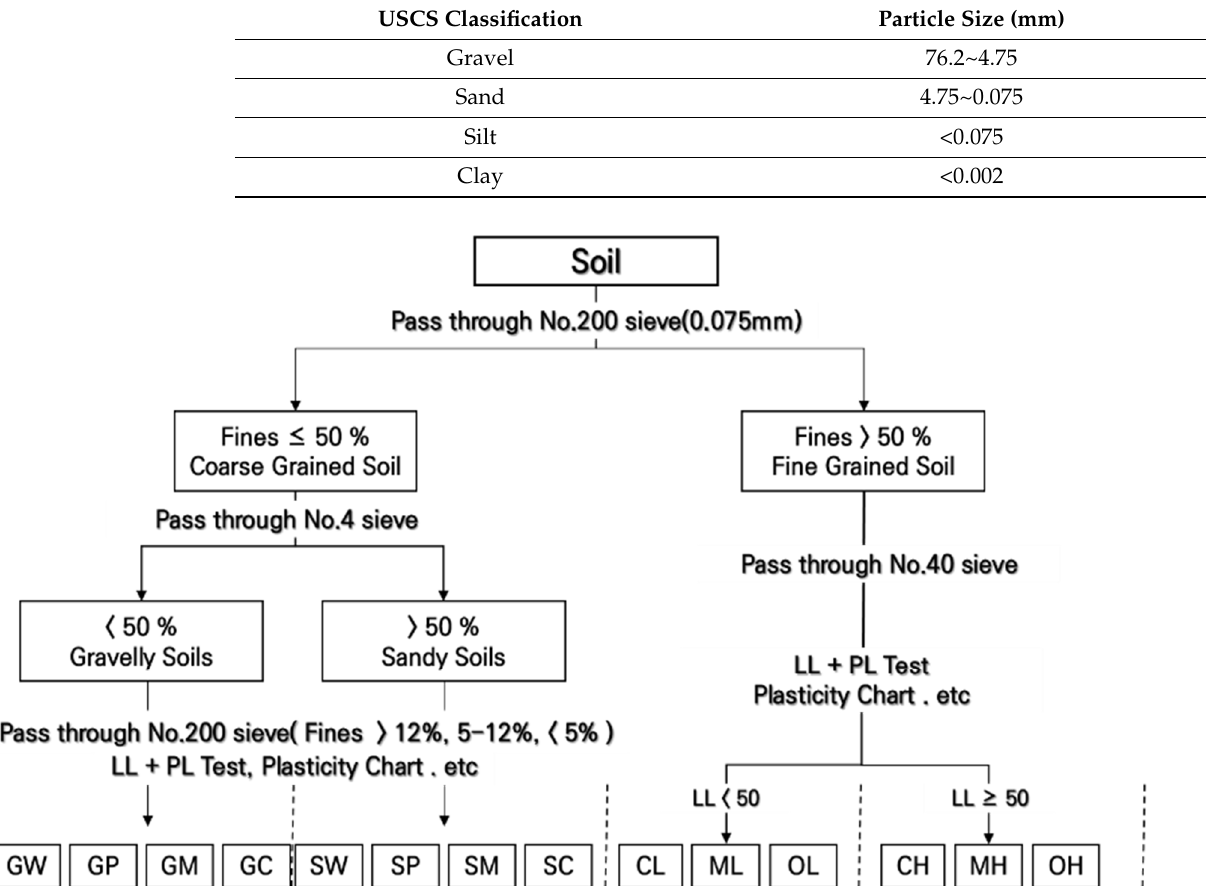
Table 1. Summary of particle size classification using the Unified Soil Classification System.